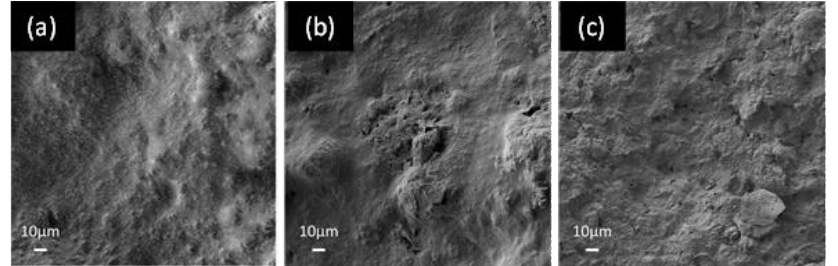
Figure 8. FE-SEM images of the surfaces of: ( a ) the polyurethane unfilled matrix (neat paint); ( b ) the produced sensor with 4.5 wt.% of GNPs; ( c ) the lossy sheet of RAS obtained using 8 wt.% of GNPs.